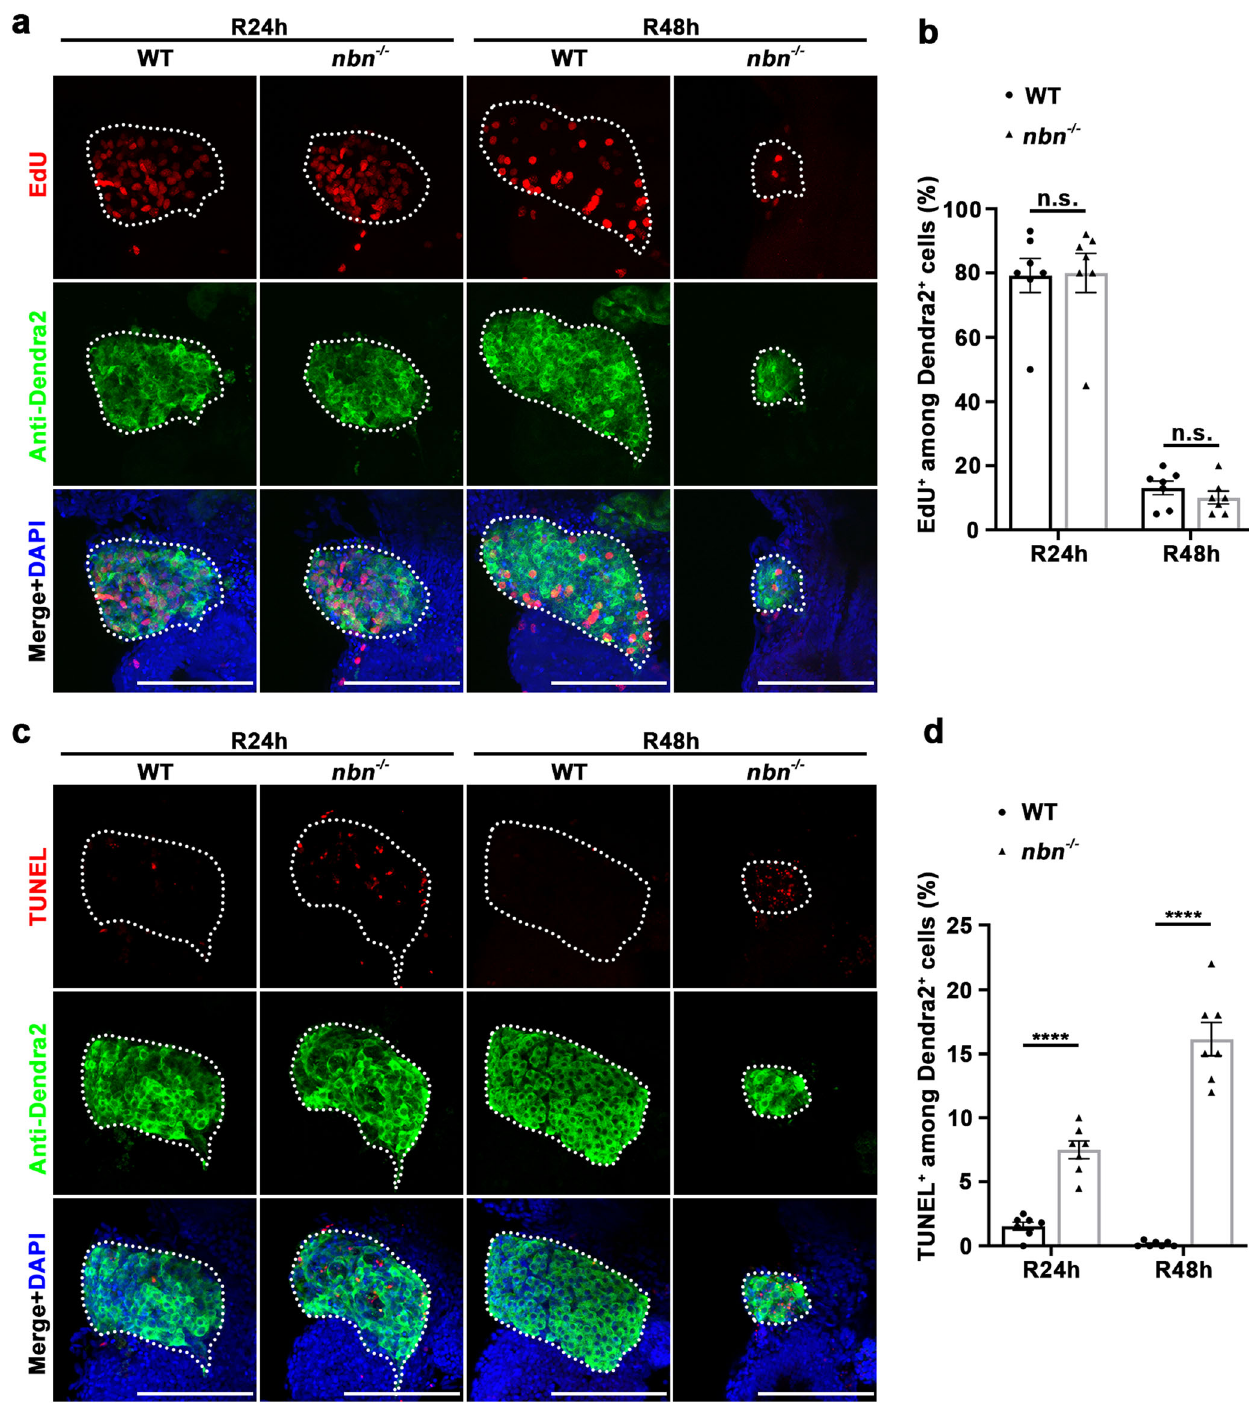
Fig. 4 The nbn mutant exhibits normal cell proliferation but aberrant cell apoptosis. a Confocal z-stack projection images showing the label of EdU (red), Dendra2 (green), and DAPI (blue) in regenerating livers at R24h and R48h in wild-type and nbn mutant. b Quanti fi cation of the percentage of EdU + cells among Dendra2 + cells, n = 7 larvae per group. c Confocal z-stack projection images showing the label of TUNEL (red), Dendra2 (green), and DAPI (blue) in regenerating livers at R24h and R48h. d Quanti fi cation of the percentage of TUNEL + cells among Dendra2 + cells, n = 7 larvae per group. Asterisks indicate statistical signi fi cance: **** P < 0.0001 using t -tests analysis when compared to control. Scale bars, 100 μ m; error bars, ±SEM. R regeneration time after the withdrawal of Mtz, WT wild-type, DAPI 4 ′ , 6-diamidino-2- phenylindole, n.s. no signi fi